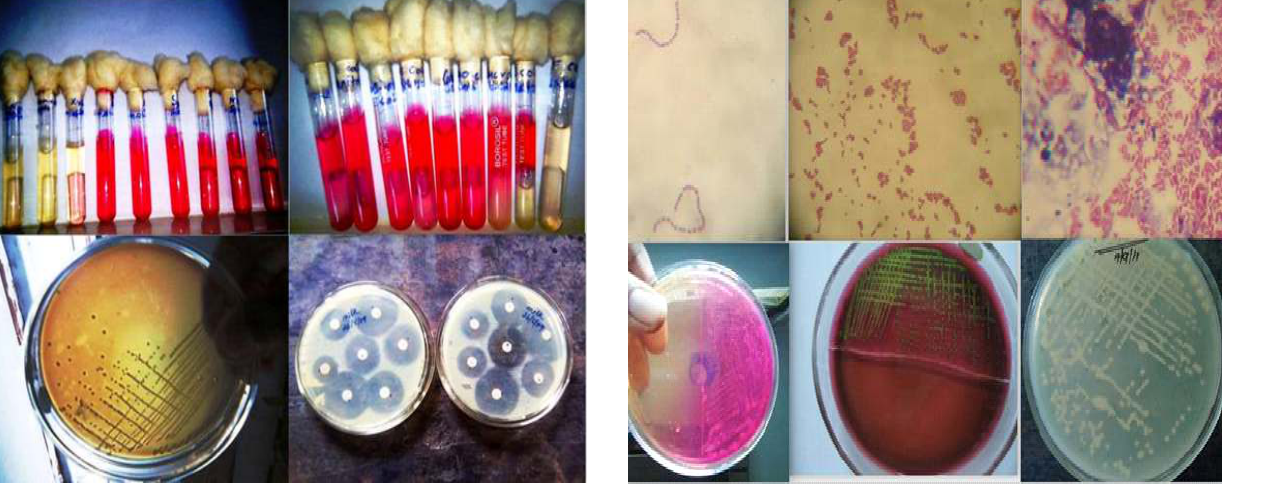
Figure-1. From top left to right: Sugar fermentation test to identify S taphylococcus , Sugar fermentation test to identify E.coli , isolates.spp Haemolytic colonies of Streptococci spp on blood agar, Antibiotic sensitivity test of the